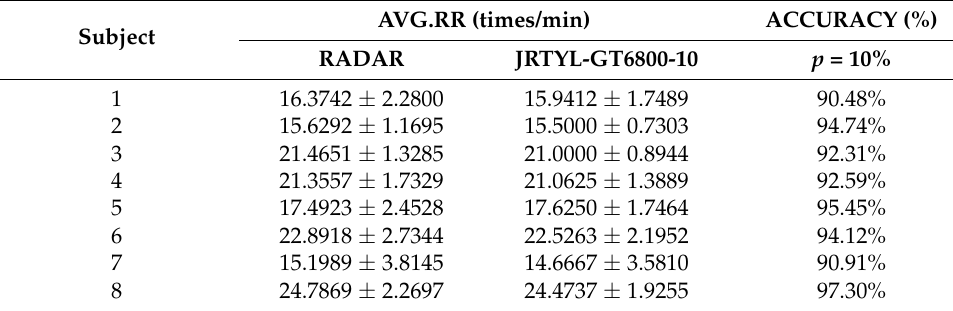
Table 1. Measurement results of the average respiratory